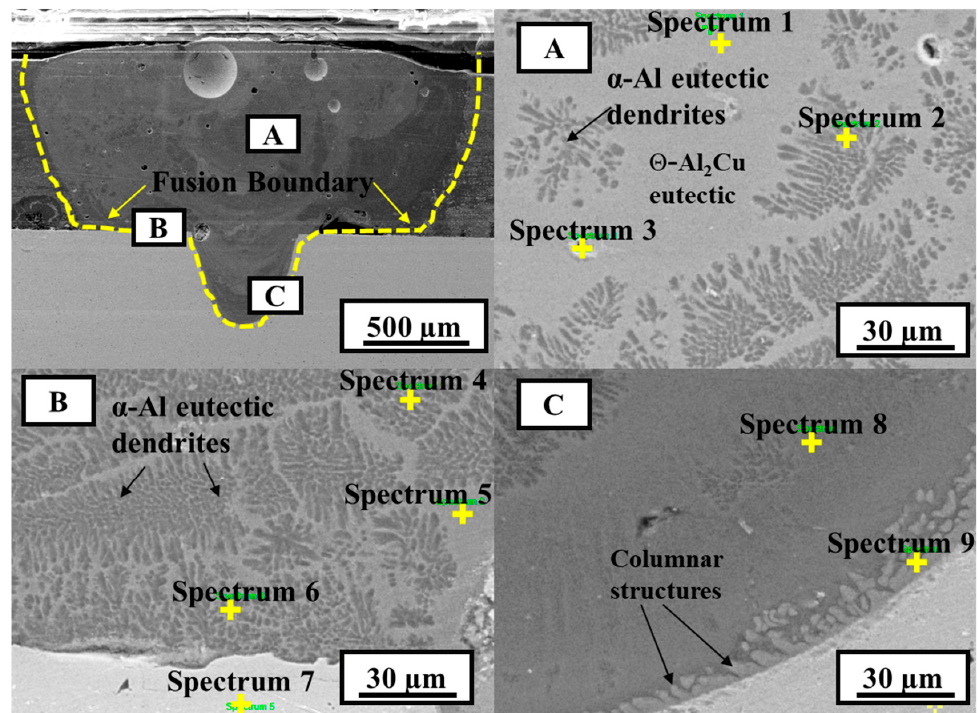
Figure 9. SEM images of sample A4 (power = 1500 W, welding speed = 30 mm/s); ( A , B , C ) are the magnified SEM images of microstructures at location A, B and C in weld fusion zone, respectively. Table 3. Chemical composition of zones denoted in Figure